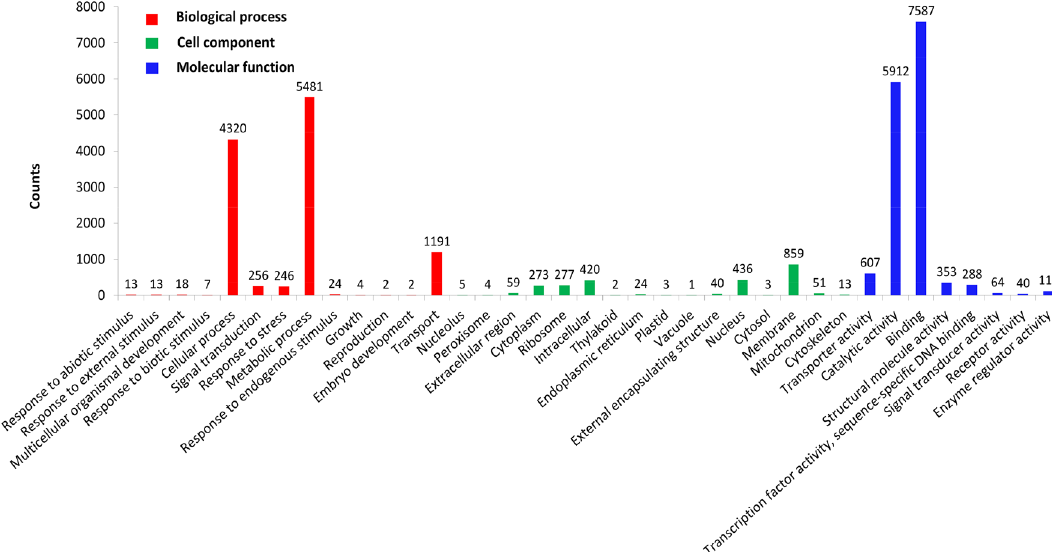
Figure 2. Unigene GO classifications. The Y-axis represents the number of a specific term of genes in each main category (Biological Process, Molecular Function, and Cellular Components) and the X-axis represents the 37